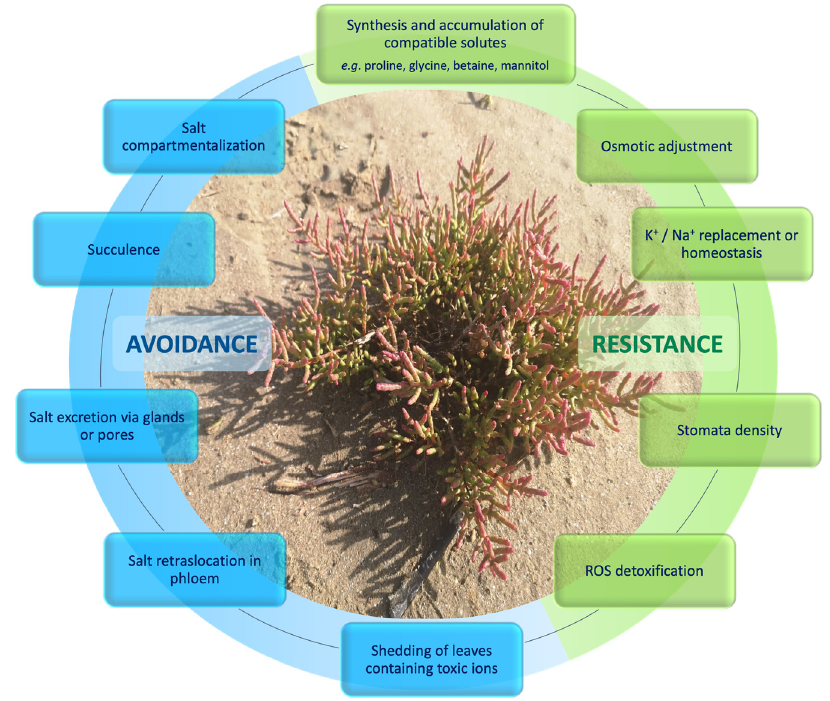
Figure 1. Response mechanisms to salinity stress by halophytic plants. Photo credit: Tiziana